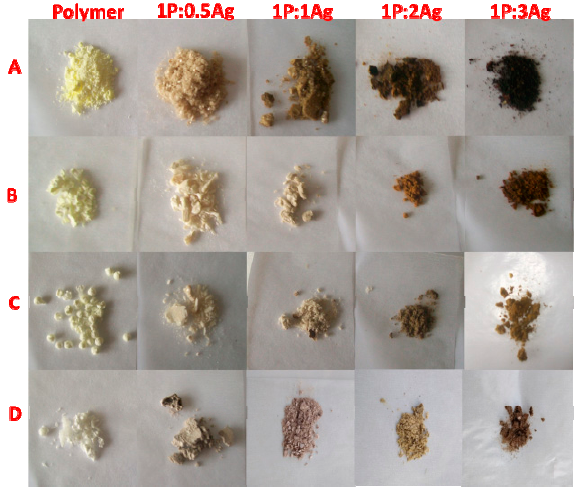
Figure 1. Photographs of the polymers ( A , B , C , D top to bottom) and the resultant nanocomposites.